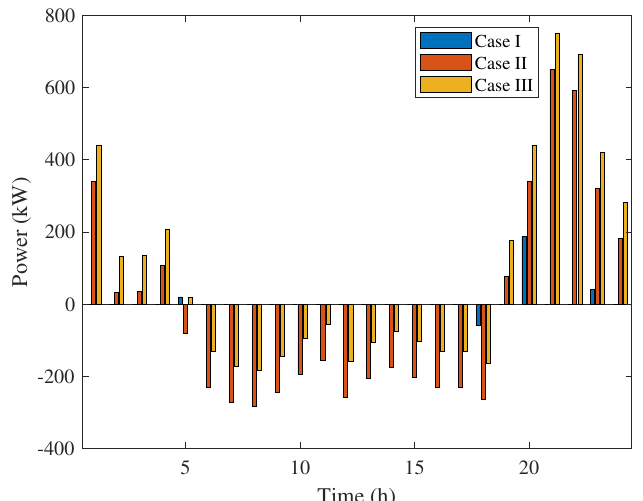
Figure 10. Hourly − shiftable demand response program in peak